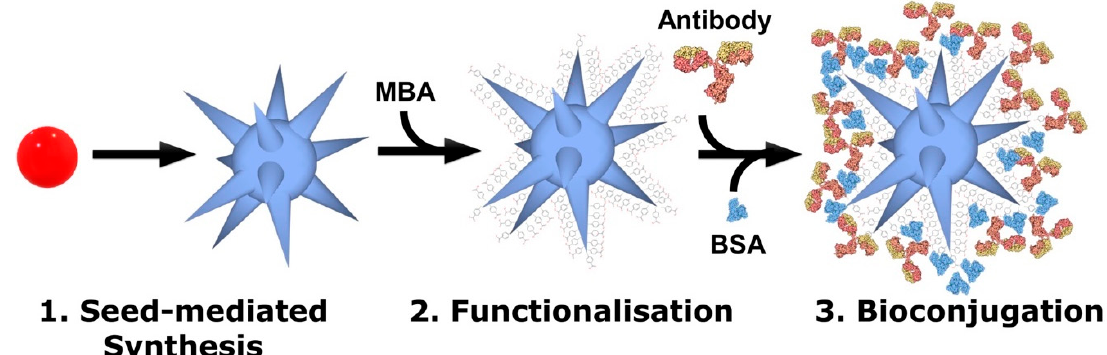
Figure 1. Schematic representation of the process to produce SERS-active bioconjugates. First, citrate- capped gold nanospheres are synthesized and used as seeds for gold nanostars synthesis. Second, the nanoparticles are functionalized with a Raman reporter. Third, bioconjugation with antibodies and blocking with bovine serum albumin (BSA) are completed by simple incubation.